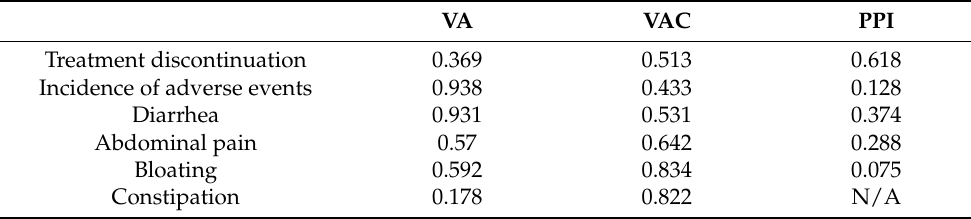
Table 5. SUCRA values concerning the safety of therapeutic interventions against Helicobacter pylori included in this Network